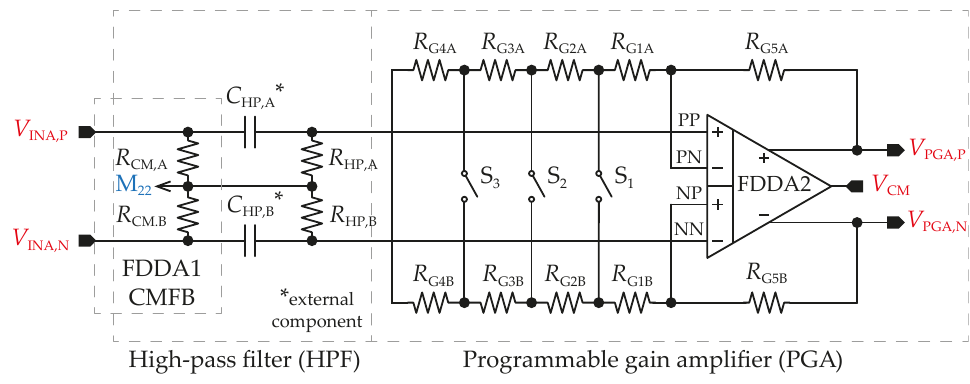
Figure 4. Topology of HPF and